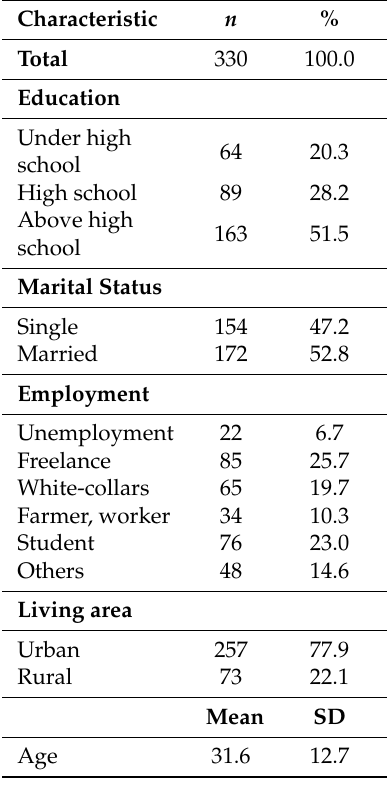
Table 1. Sociodemographic characteristics of respondents ( n =